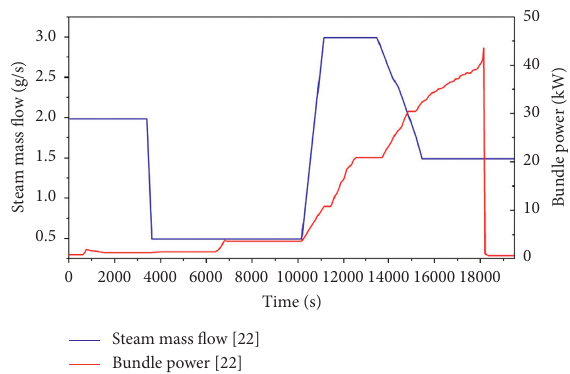
Figure 11: Bundle power and steam flow rate in Phebus FPT0. 2 volume for different